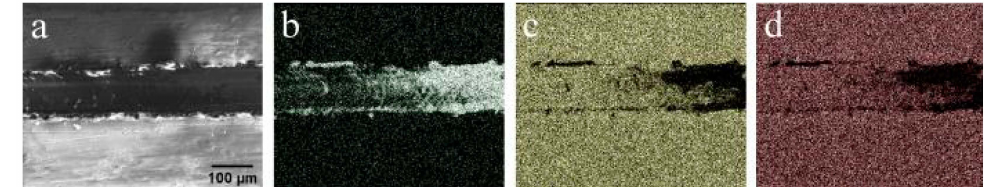
Figure 7. ( a ) SEM image of a track after scratch test for Zn-CaP coating on Ti–6Al–7Nb substrate, and EDX mapping of that region showing distribution of ( b ) Ti, ( c ) Ca, and ( d ) P elements.